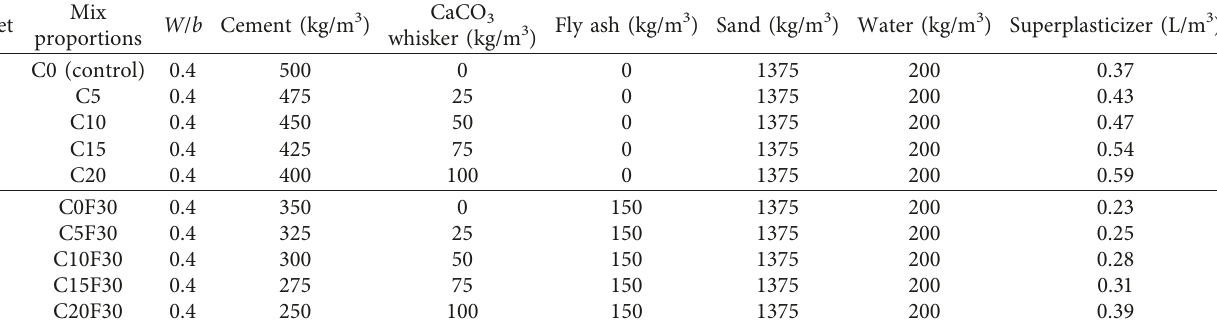
Table 2: Mix proportions of